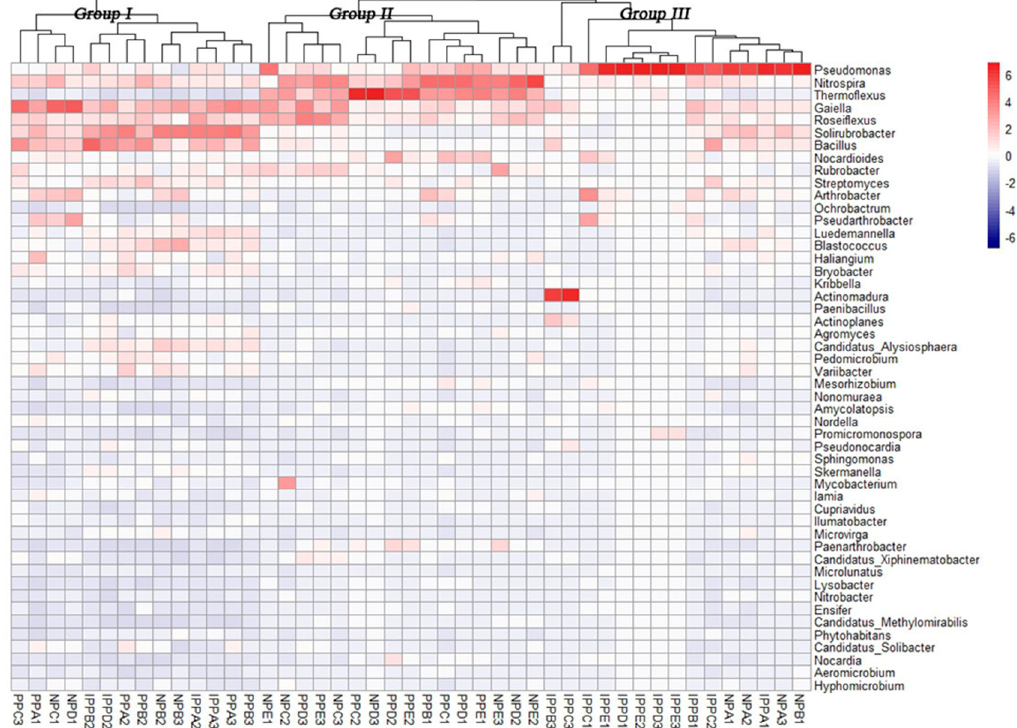
Figure 3. Heatmap of dominant genera of soil bacteria and cluster analysis of bacterial community composition across pavement types. The heatmap and clustering were computed from Operational taxonomic units (OTUs). The blue denotes low relative abundance across a bacterial taxon, and the red denotes high relative abundance.